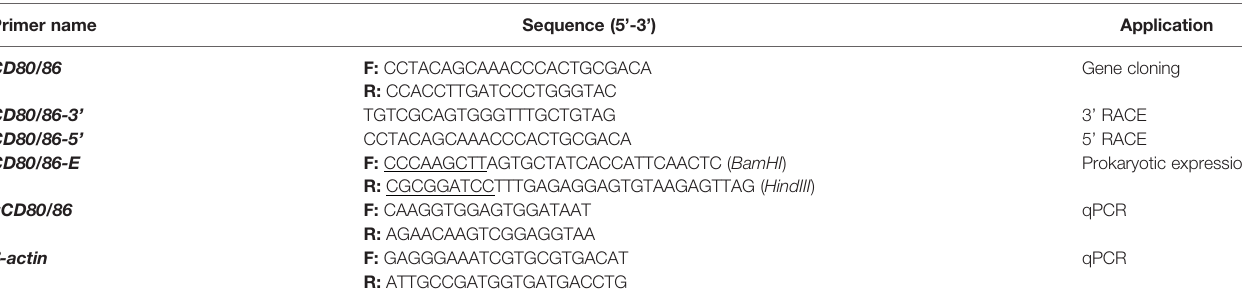
TABLE 1 | Sequences of primers used for gene